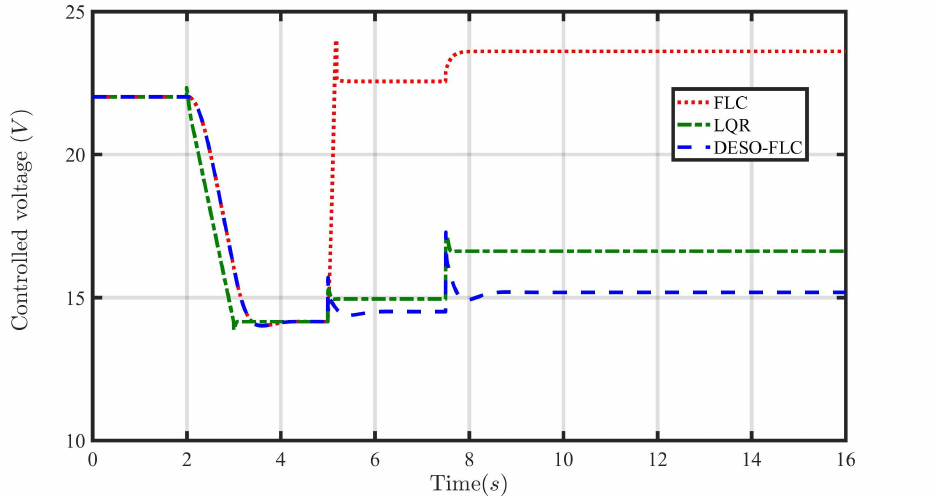
Figure 11. Response of controlled voltage ( V C ) in the presence of parametric